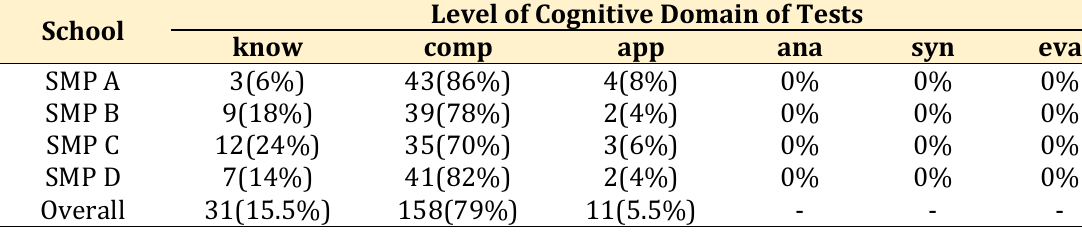
Table 6. Level of Cognitive Domain of